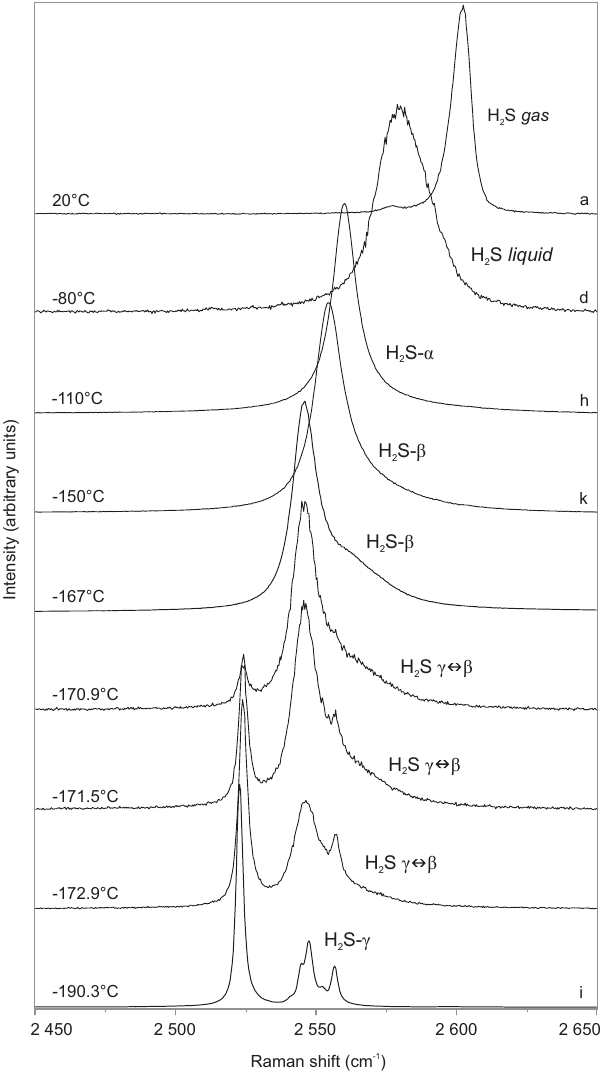
Fig. 6 Raman spectra of the stretching region of H 2 S in a natural CH 4 – H 2 S – CO 2 – N 2 – H 2 O fl uid inclusion (no. P4- fi 1B) at low temperatures. A density-related shift in Raman peak positions to lower wavenumbers with decreasing temperature is observed for different physical states of H 2 S. The measurement points (a, d, h, k, i) are indicated by green crosses in the Fig. 3. The solid H 2 S ( γ ↔ β ) phase transition is marked by intensity decrease of the characteristic peak of the β -phase and the progressive emergence of the sharp γ -phase peak at the lower wavenumber (2523cm − 1 ) and its subsequent intensity increase. The solid H 2 S ( γ ↔ β ) phase transition was recorded during real-time measurements.